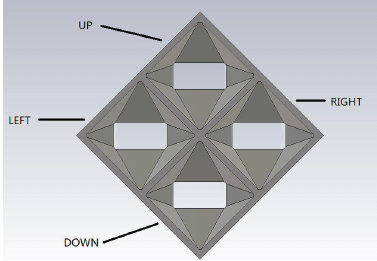
Figure 1. Diamond-shaped Cassegrain feed.